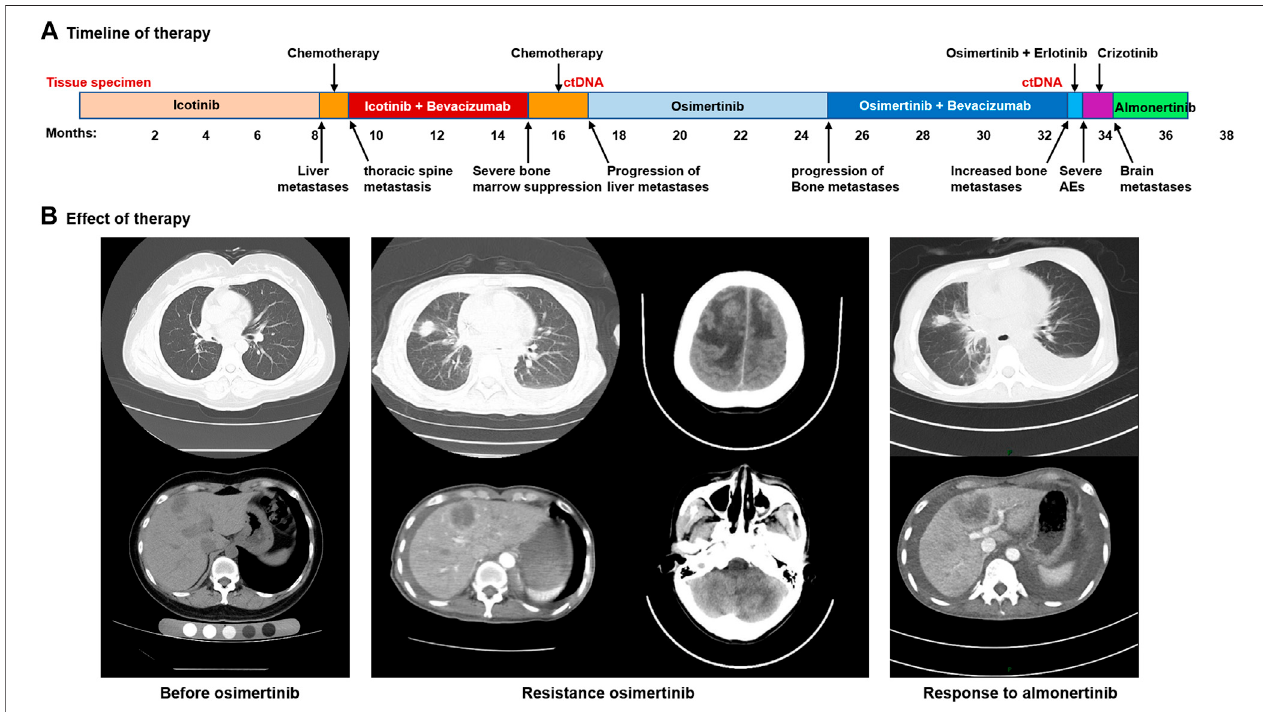
FIGURE 2 | Acquired resistance to osimertinib and response to almonertinib. (A) , the various treatments the patient received and the duration of the various treatments. (B) , images of the patient ’ s metastatic lung, liver and brain